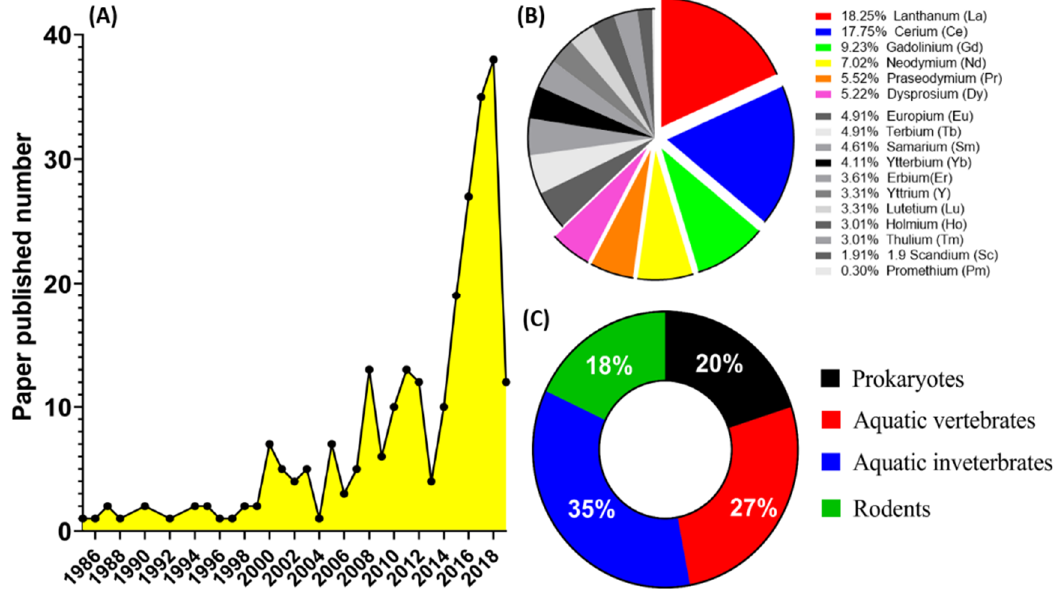
Figure 1. Summary of the rare earth elements (REEs) related research based on published year, REEs species, and toxicity testing animals. ( A ) Number of literatures each year in the eco-toxicity field from 1985–2019. Literature related to rare earth elements was searched in PubMed, Science Direct, and Google Scholar, and the number of literatures was then broken down according to the year. ( B ) Pie chart summarized the number of literatures for each rare earth element (REEs) eco-toxicity test from 1985–2019. The number of literatures was then broken down according to the REEs species. ( C ) Pie chart summarized the number of literatures of model organisms used to analyze REEs toxicity. The model organisms are classified into: prokaryotes, aquatic vertebrates, aquatic invertebrates, and rodents.